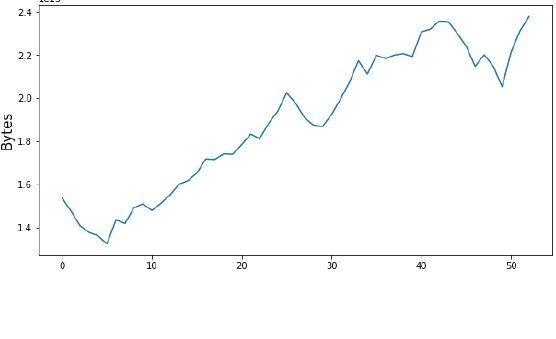
Figure 3. Monthly SoCal working set size for analysis jobs using MINIAOD and MINIAODSIM data tiers. Data obtained from MONIT